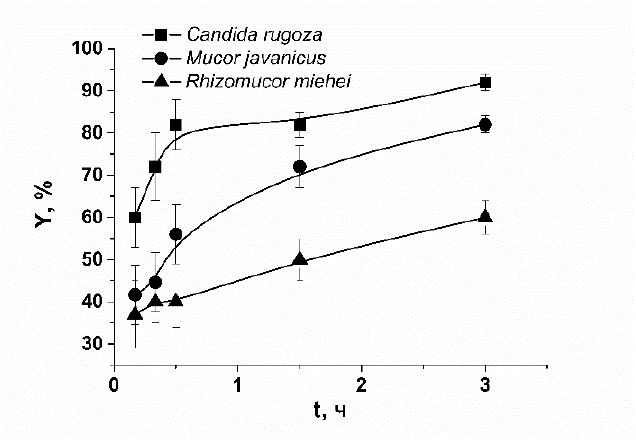
Figure 1. Lipase release from κ -carrageenan-based hydrogel microspheres.